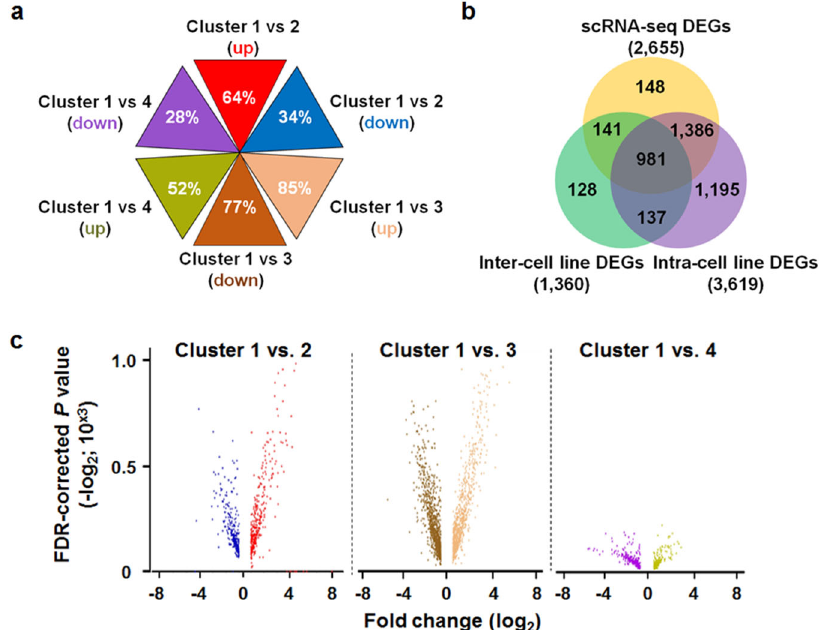
Fig. 2 Characterization of DEGs detected from Fluidigm 3 ′ -end scRNA-seq dataset. a Hexagonal triangle diagram indicates the percentage of scRNA-seq DEGs uniquely detected in up- or down-regulated gene set per cluster comparison. b Venn diagram presenting scRNA-seq DEGs ( n = 2,655), intra-cell line DEGs ( n = 1,360), and inter-cell line DEGs ( n = 3619). Individual values indicate the number of unique or overlapping DEGs among the three DEG sets. c Volcano plots showing correlation between values of scRNA-seq DEG fold change (log 2 ; x axis) and FDR- corrected P (<0.05; − 10 3 × log 2 ; y axis) per up- or down-regulated gene set from cluster comparison. Individual DEGs are presented in the color-matching dots per gene set as in ( a